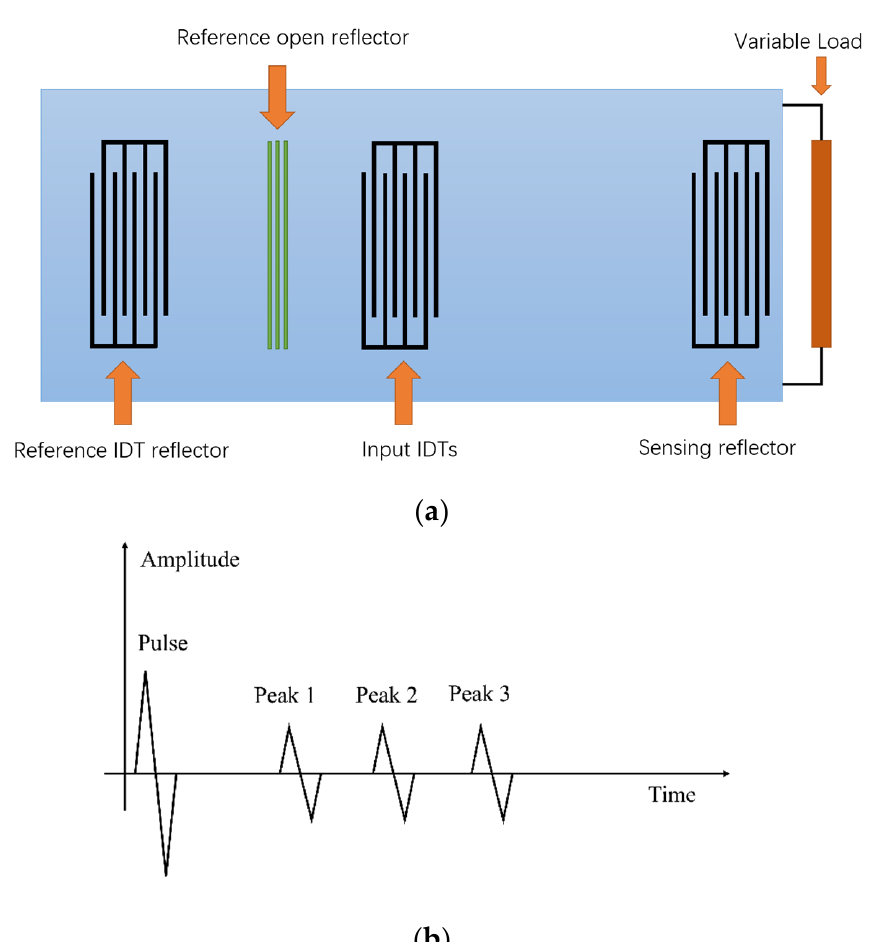
Figure 4. SAW device’s design and its expected result in time domain: ( a ) the utilized SAW device for which IDTs and reflectors have 22 fingers; electrode material is aluminum and substrate material are 128° YX LiNbO3 and ( b ) the expected received signal in the time domain. Peak 1 is the reflection from the reference open reflector, Peak 2 is a reflection from the reference IDT reflector, and Peak 3 is the reflection from the sensing reflector.